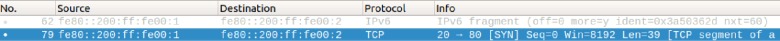
Host-B receives a fragmented TCP packet.